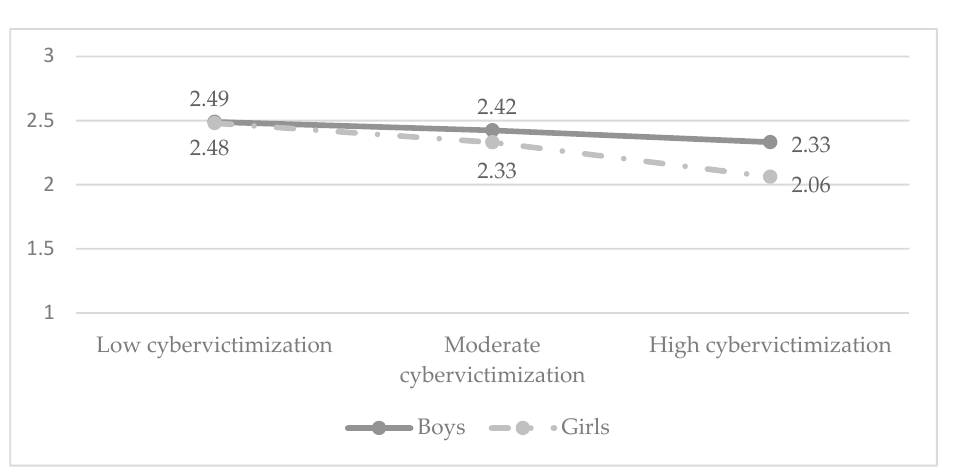
Figure 1. Cybervictimization, family functioning and gender.